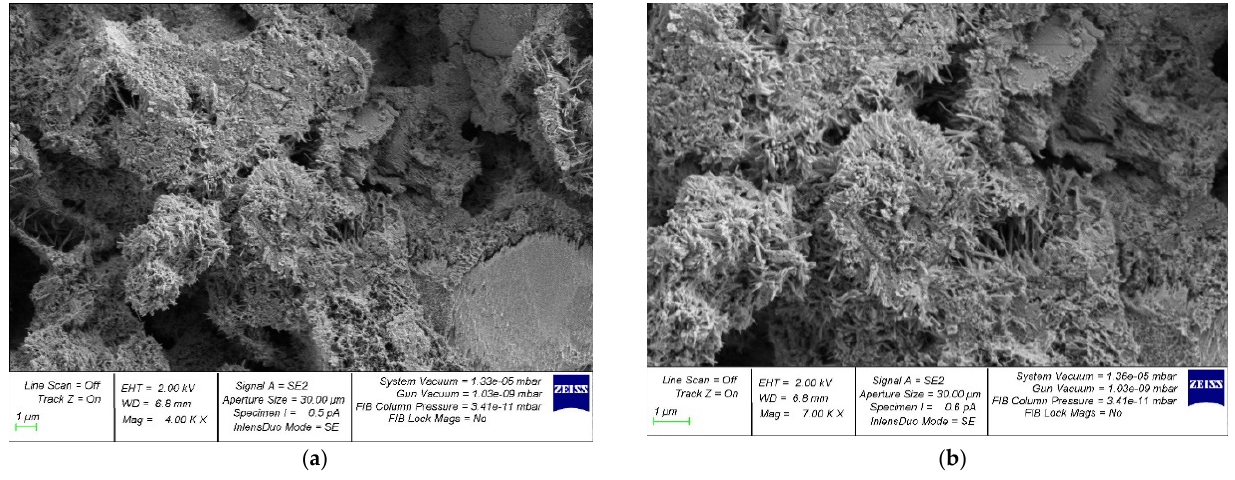
Figure 8. Photo of samples of centrifuged hardened cement paste: ( a ) at 4000× magnification; ( b ) at 7000× magnification.